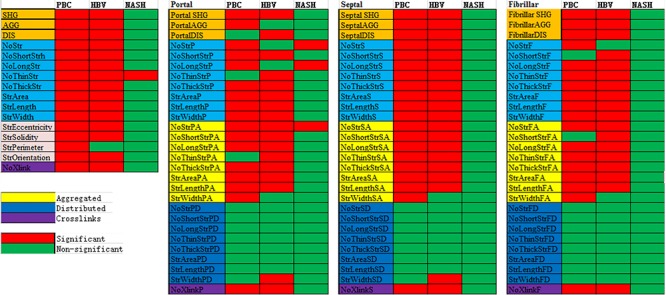
Results of one-way ANOVA analysis of parameters in portal, septal and fibrillar areas with liver fibrosis stages in samples from chronic hepatitis B (CHB), primary biliary cirrhosis (PBC), and non-alcoholic steatohepatitis (NASH). Orange, light blue and gray colors are used for differentiation of different parameters. SHG, second harmonic generation; AGG: aggregated collagen percentage; DIS: distributed collagen percentage. See Supplementary Table S1 for details.